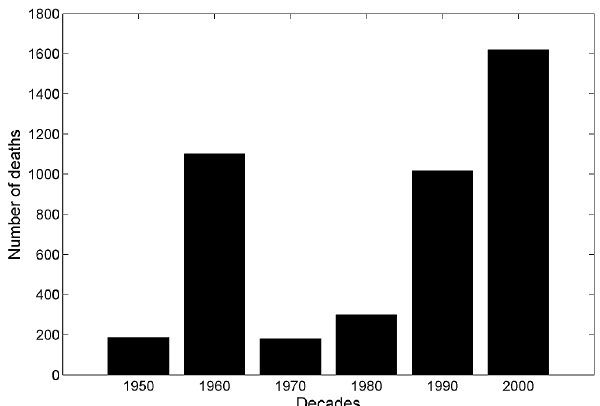
Fig. 1. Fatalities caused be floods between 1950 and 2009 in Alge- ria, Morocco and Tunisia (data from EM-DAT: The OFDA/CRED International Disaster Database – www.emdat.net –